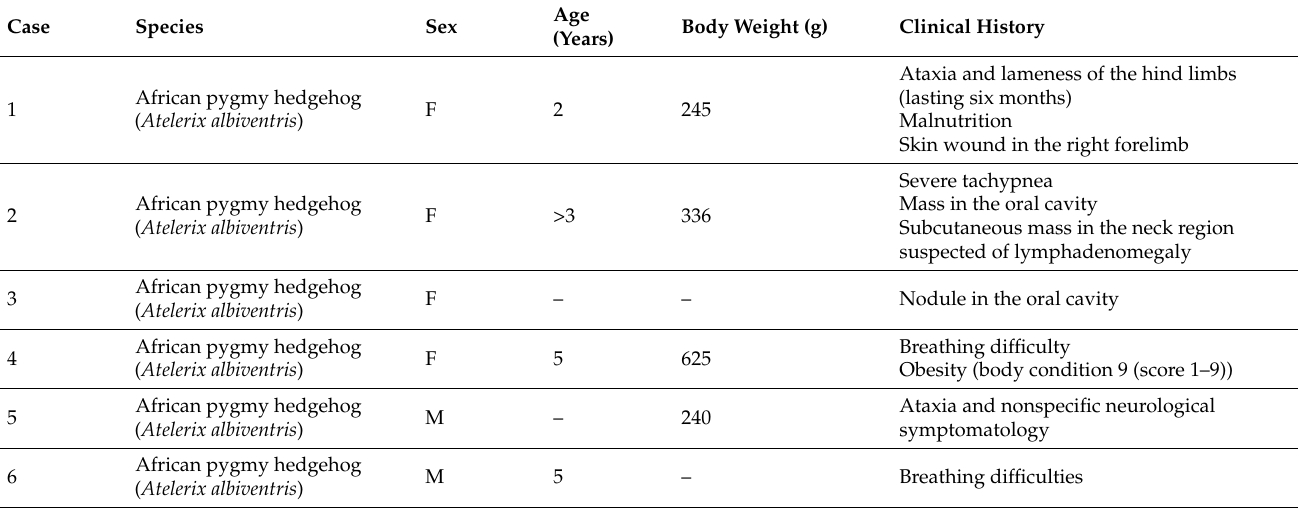
Table 1. Detailed information about the animals included in the study.